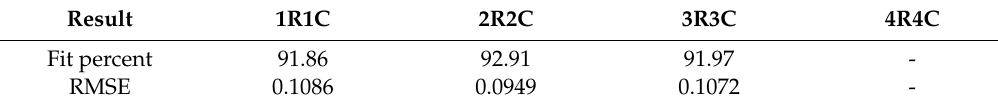
Table 5. Thirty-minute prediction results for experiment A.